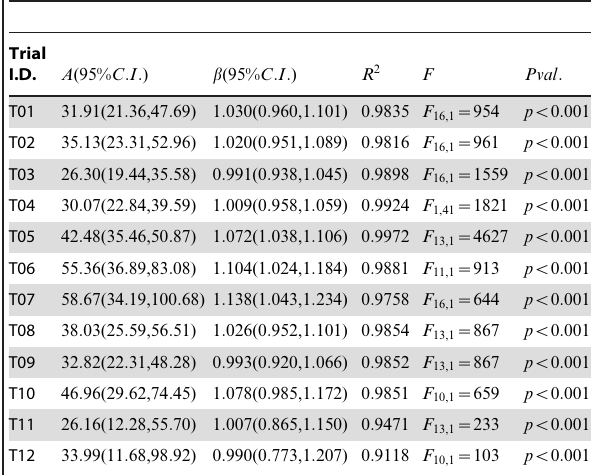
Table 2. Fit of eq. 4 parameters from individual replicates when assuming pheromone